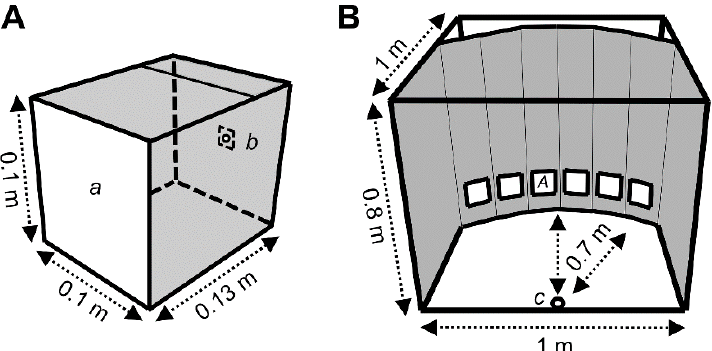
Figure 1. Schemes of LED trap and choice arena. ( A ) LED trap with acrylic glass screen front side ( a ) and LED panel backside ( b ). The inner side of the box was laminated with mirror film. ( B ) Choice arena with thrips release point ( c ) and position of LED traps ( A ). The background was black and the bottom was black-brown. In experiments with less than six traps, the not used openings on the background were covered with black foil.